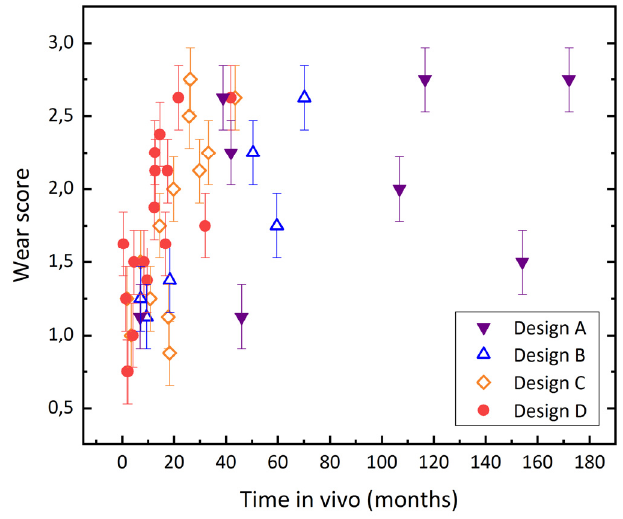
Figure 6. Coupling wear score increases with time in vivo.